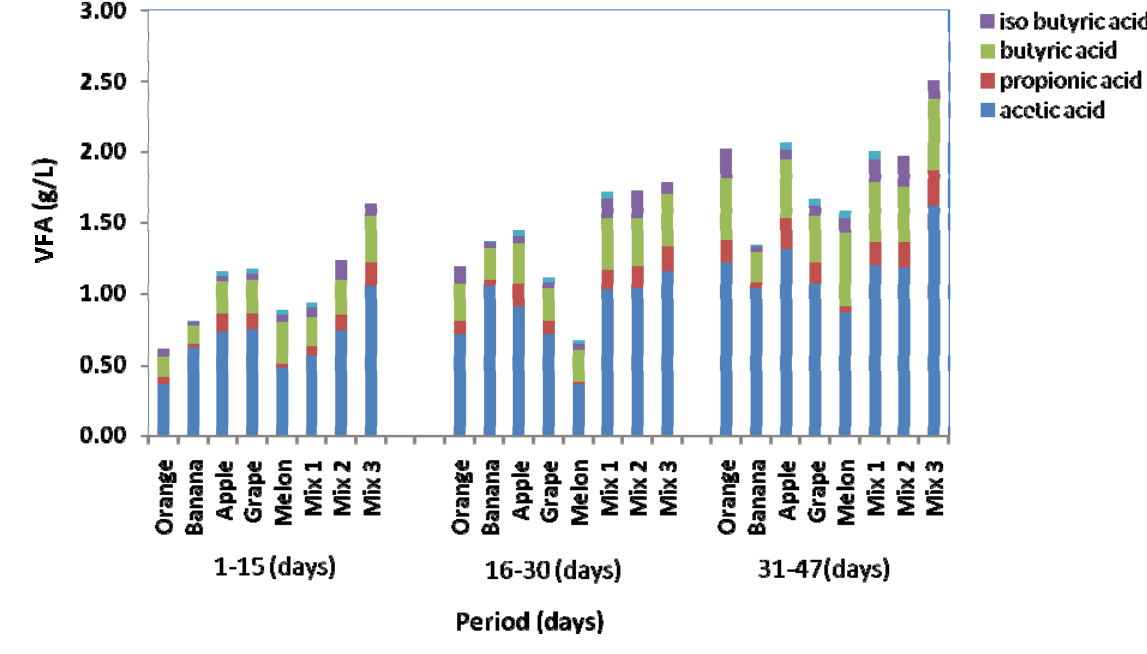
Figure 3. Volatile fatty acid (VFA) composition of the fermentation